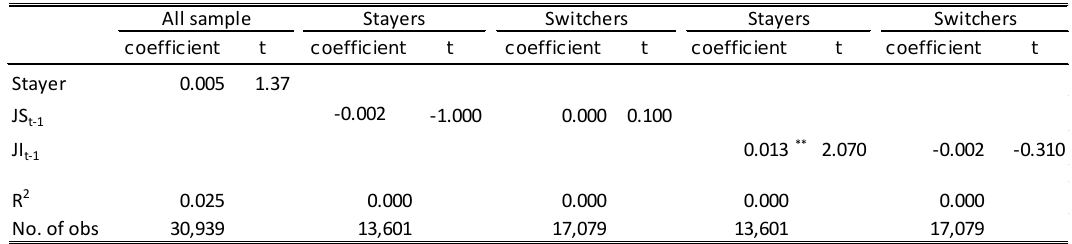
Table 10 . Cross-industry sorting, offshoring, job satisfaction and job